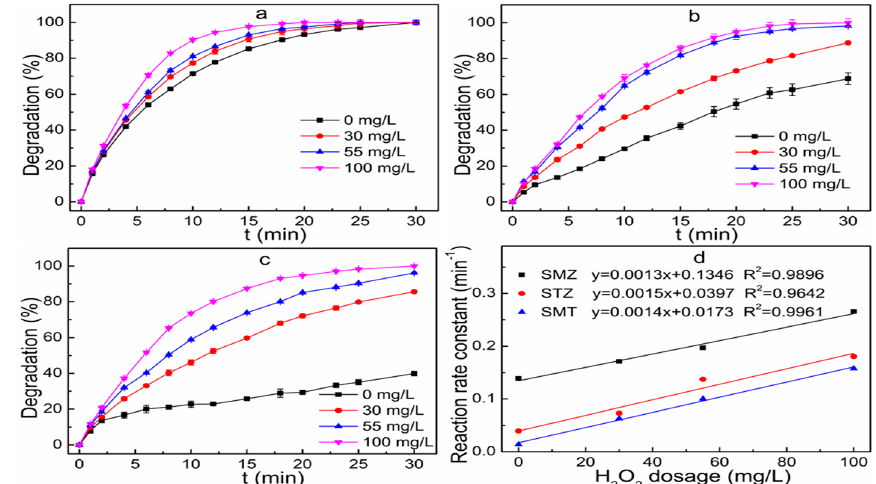
Figure 4. Effect of H 2 O 2 dosage on the removal of SMZ ( a ), STZ ( b ) and SMT ( c ) and reaction rate constant as a function of H 2 O 2 dosage ( d ). Reaction conditions: initial concentration of the mixed solution 100 μ g L − 1 , UV light intensity 5 W.